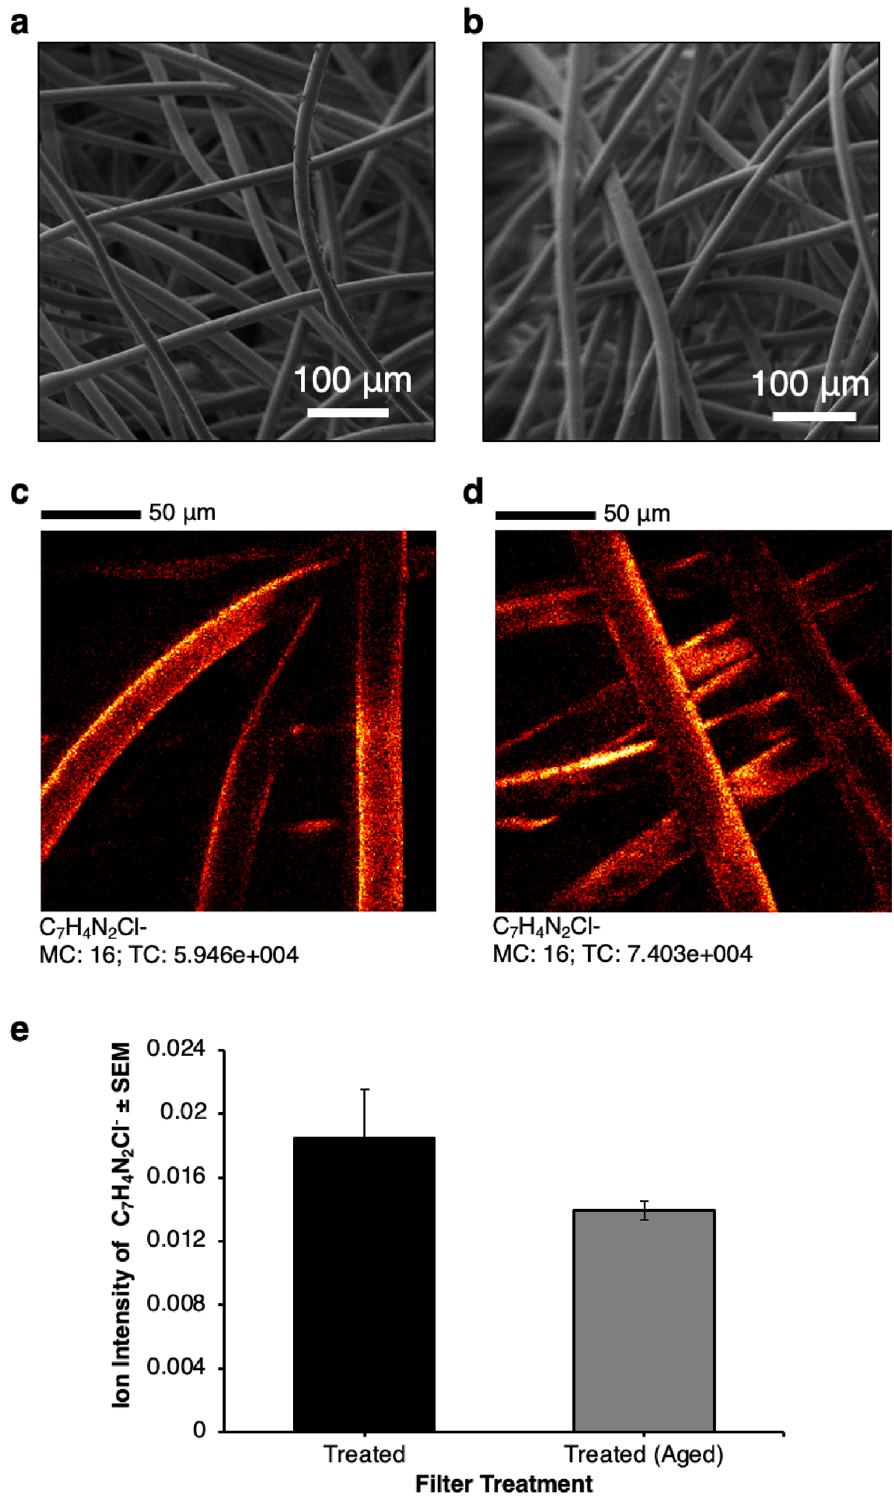
Figure 6. Characterisation of filters following aging. ( a ) SEM images of antimicrobial treated filter, image is representative of all images, scale bar 100 μm. ( b ) SEM images of antimicrobial filter after ageing, image is representative of all images, scale bar 100 μm. ( c ) ToF SIMS of a treated filter. Image is representative of all images, scale bar 50 μm. ( d ) ToF SIMS of an antimicrobial treated and aged filter. Image is representative of all images, scale bar 50 μm. ( e ) Graph shows the average ion intensity for treated filters before and after ageing, n = 4, error bars show standard error of the